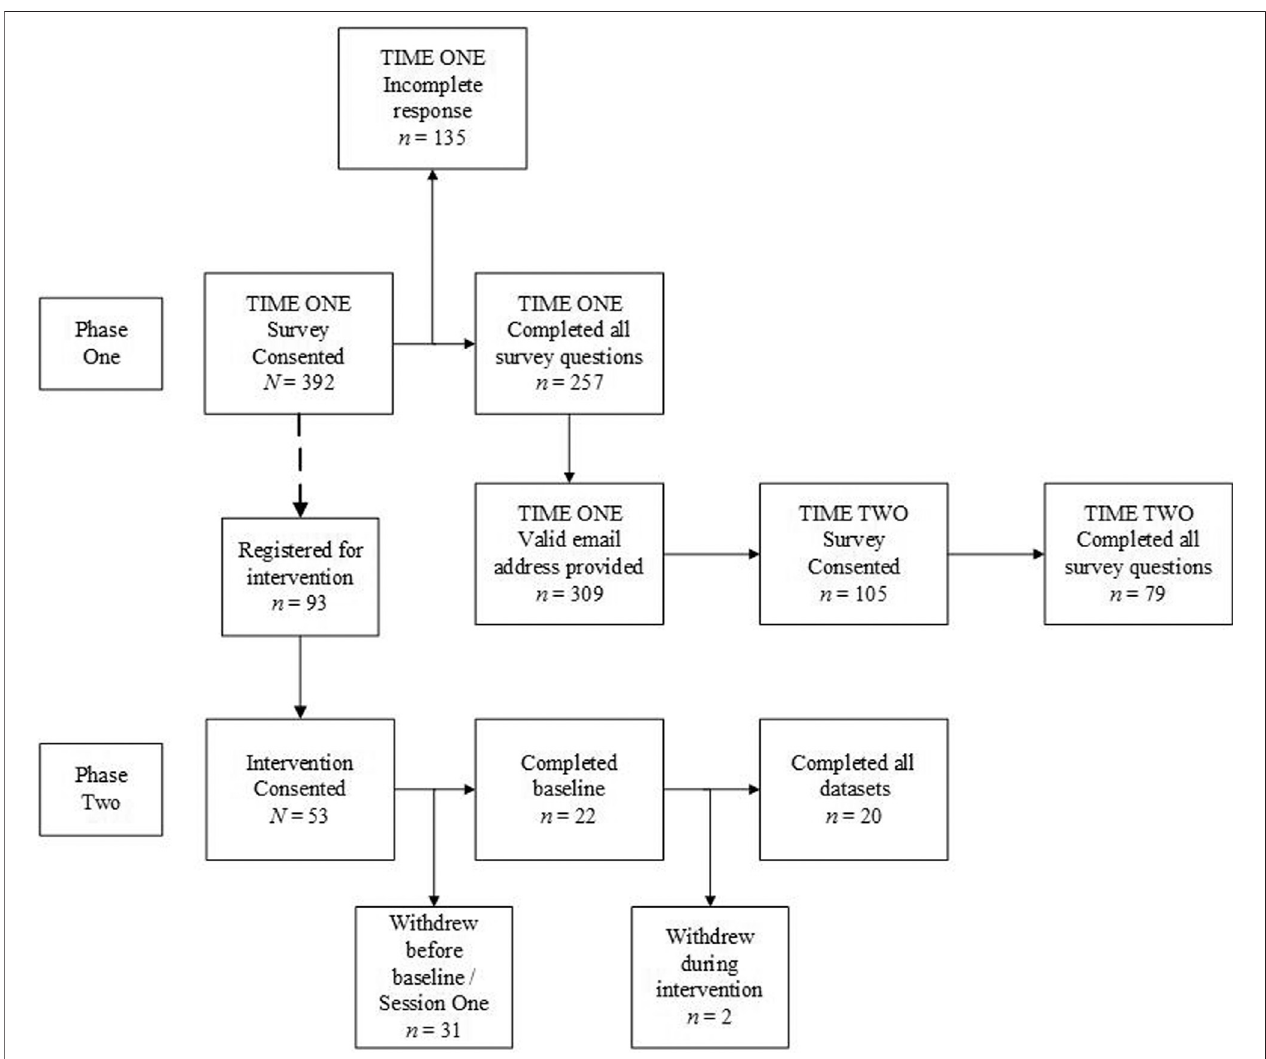
FIGURE 2 | Participant fl ow diagram for Phase One and Phase